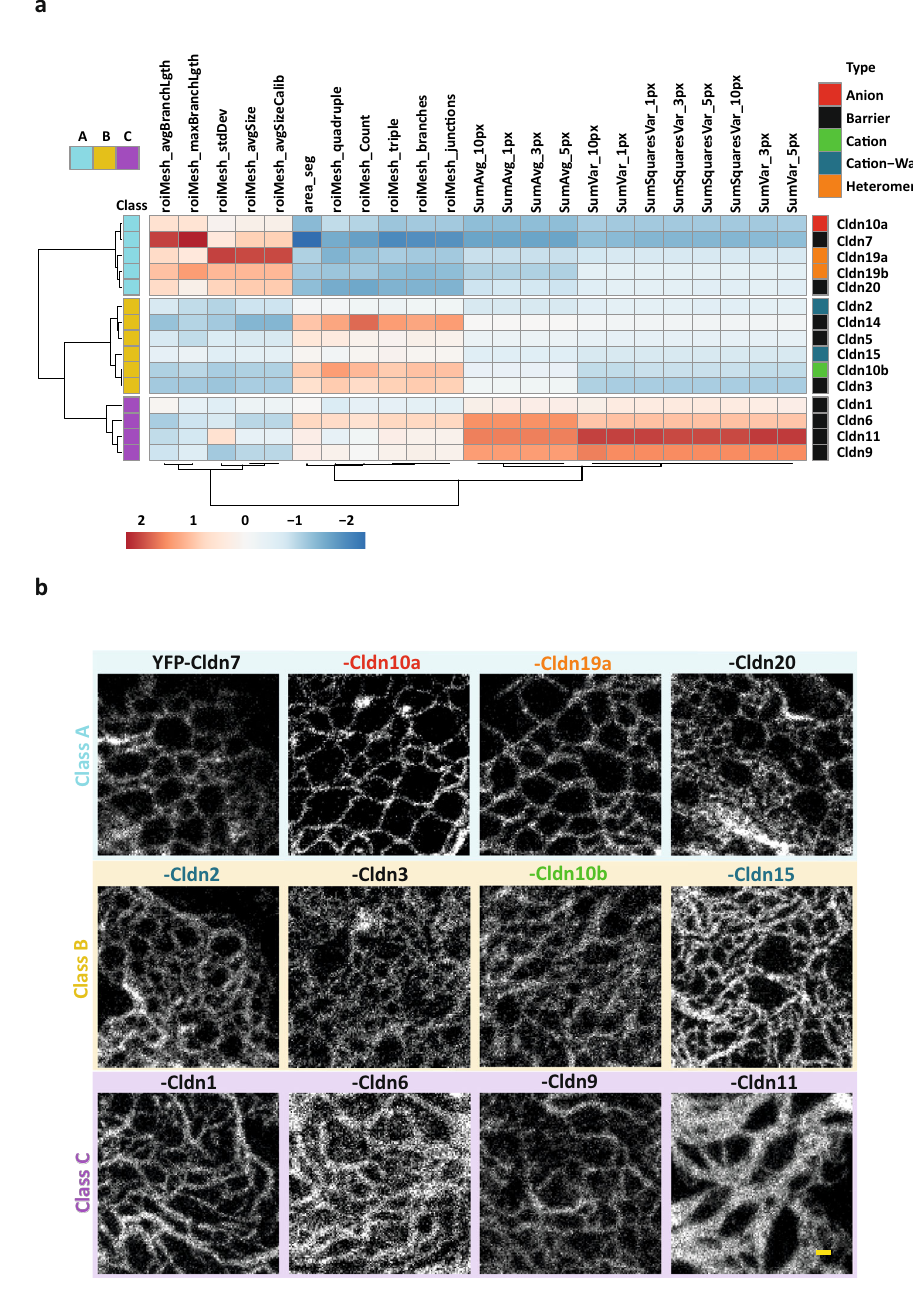
Fig.2|AutomatedanalysisofTJmeshworkenablestheoverallclassi fi cationof allmeshwork-formingclaudins.a Hierachicalclusteringofallmeshworkforming mammalian claudins expressed in COS-7 cells into three different classes using an automatedanalysisbasedonHaralicktexturefeaturesandimagesegmentation.All claudins were N-terminally tagged with YFP or GFP and boosted with α